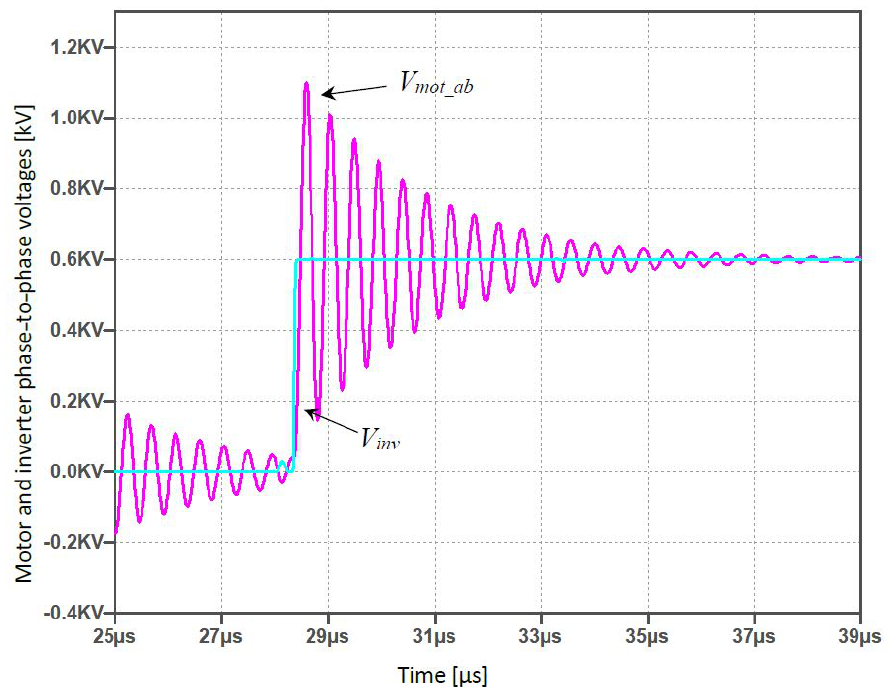
Figure 4. Transient voltage at motor terminals for 5 m lead